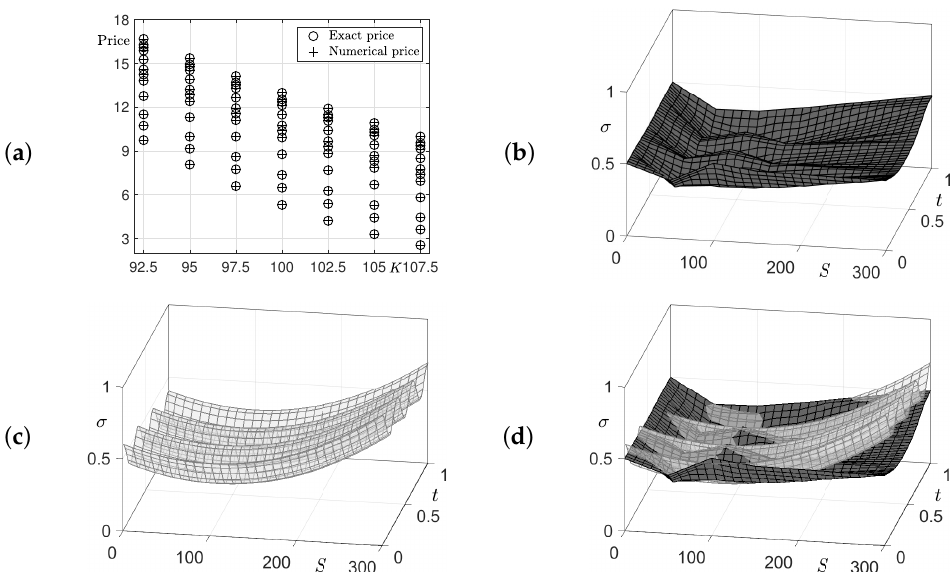
Figure 7. ( a ) Option prices computed using the given and reconstructed local volatility functions. ( b ) Reconstructed local volatility function. ( c ) Given local volatility function σ ( S , t ) = 0.00001 ( S − S 0 ) 2 + 0.1cos ( 6 π t ) − 0.2 t + 0.4. ( d ) Overlapped surfaces of ( b , c ).